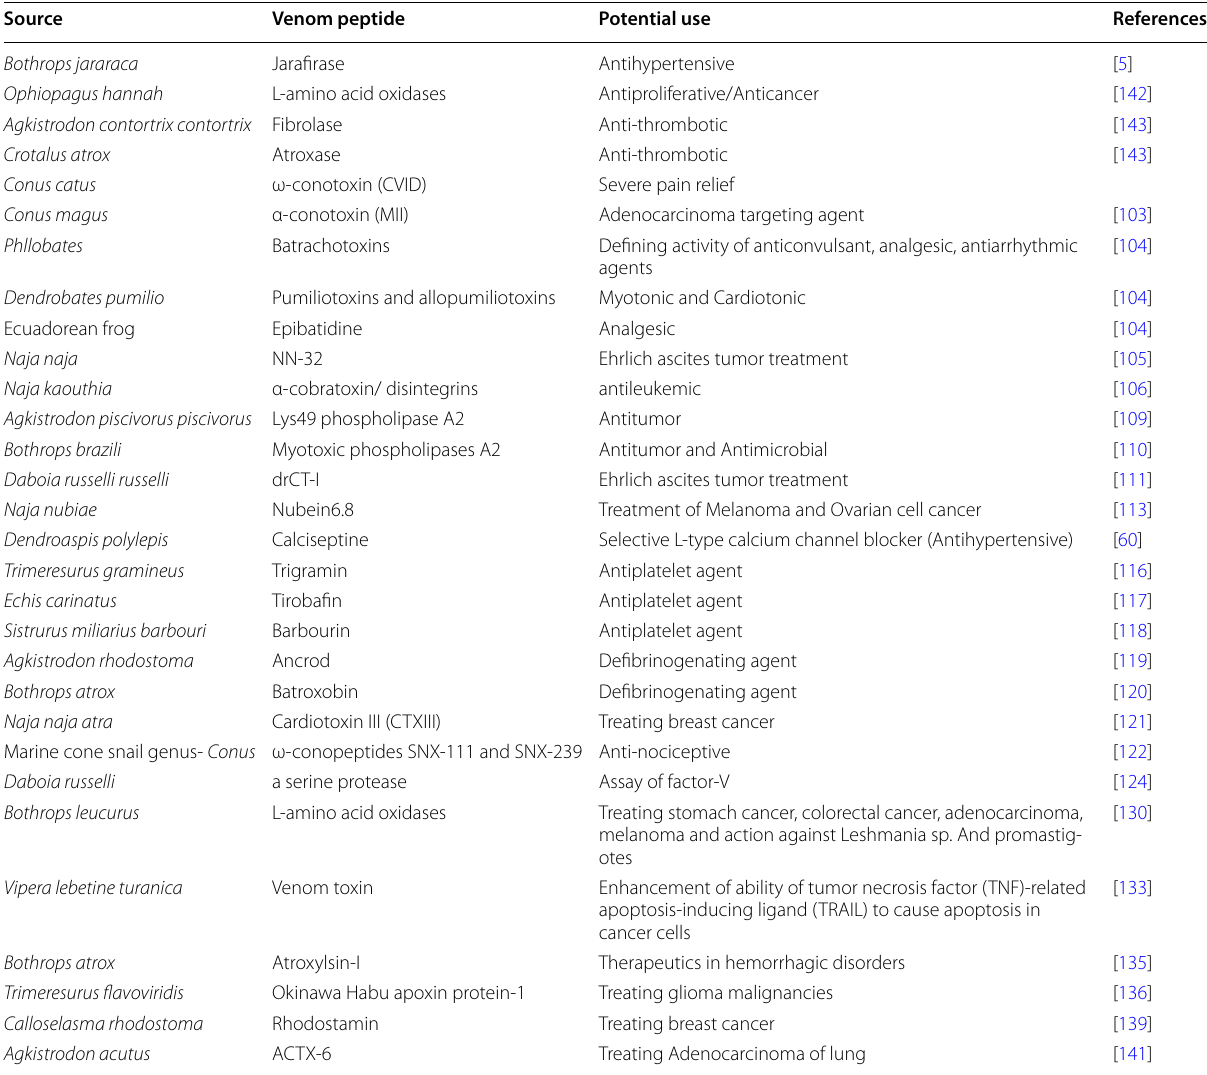
Table 2 Summary of venoms peptides and their uses